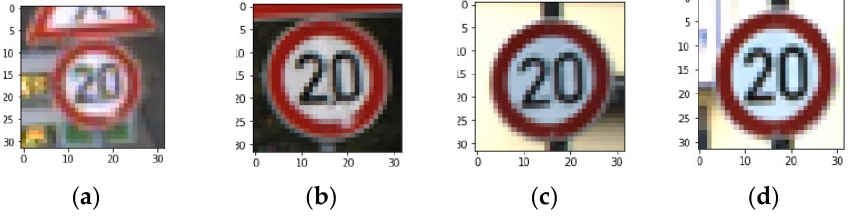
Figure 7. ( a ) RGB +/255 Mean ( b ) RGB +/255 Mean +STD ( c ) LHE +/255 Mean and ( d ) LHE +/255 Mean +STD.